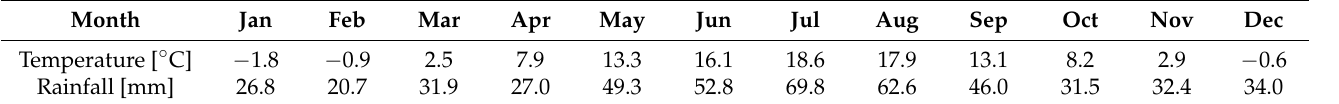
Table 1. Meteorological conditions (30-year mean) in the area of the field